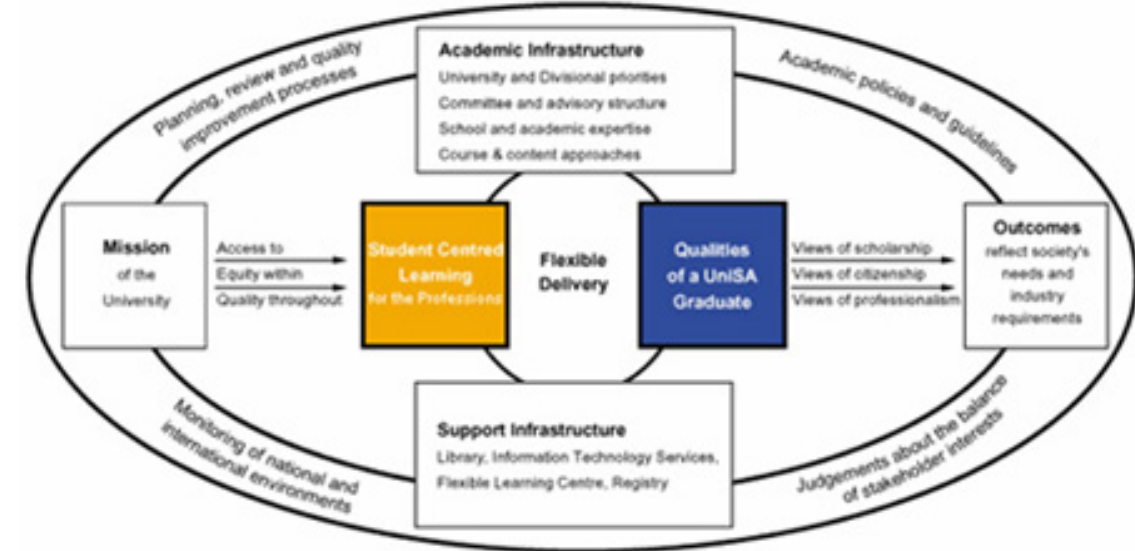
Figure 1: Systems and processes model of teaching and